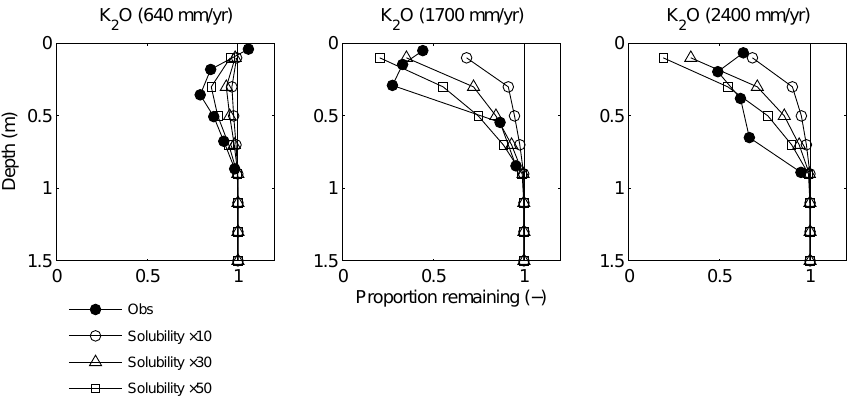
Figure 8. Observed vs. simulated K for the 10ka Kona flow for 3 different simulations of increased K